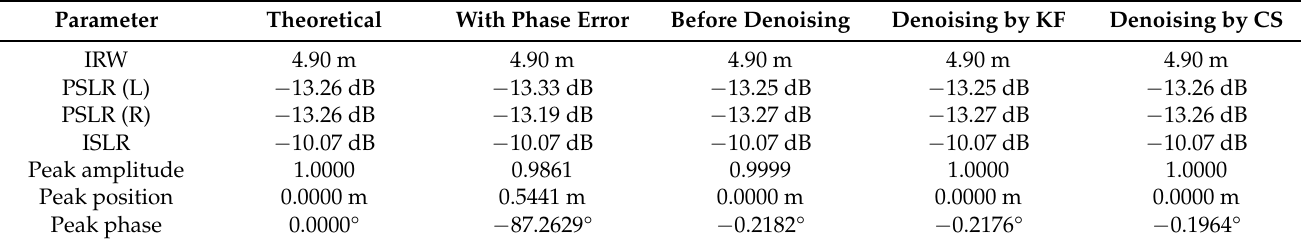
Figure 9. Result of phase denoising. ( a ) Synchronization phases (the phases are shifted for clear display). ( b ) Local zooming of synchronization phases. Table 3. Parameters of the response after azimuth